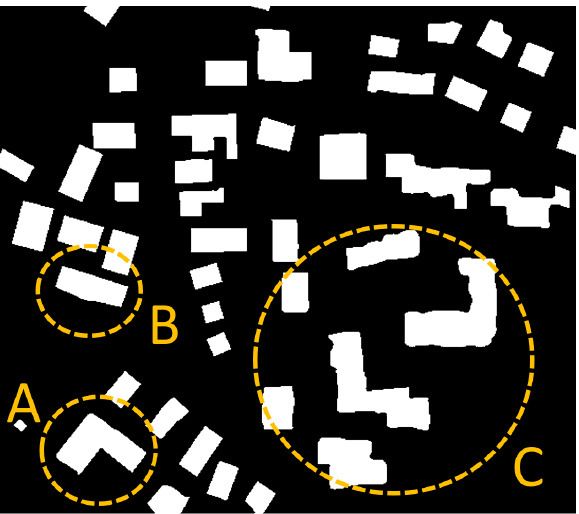
Figure 7. Target output by CHANGE for scale 1:15.000